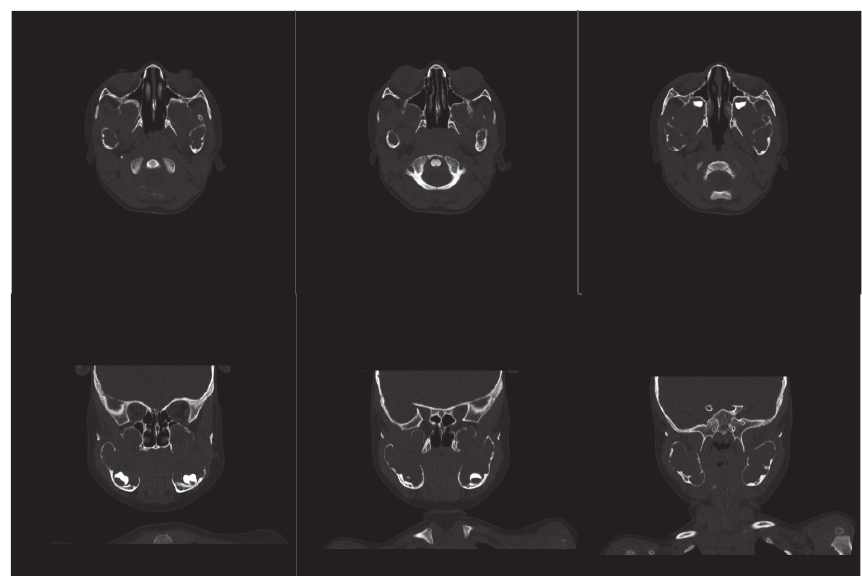
Figure 3: Axial and coronal views of lesion in maxilla and mandible.